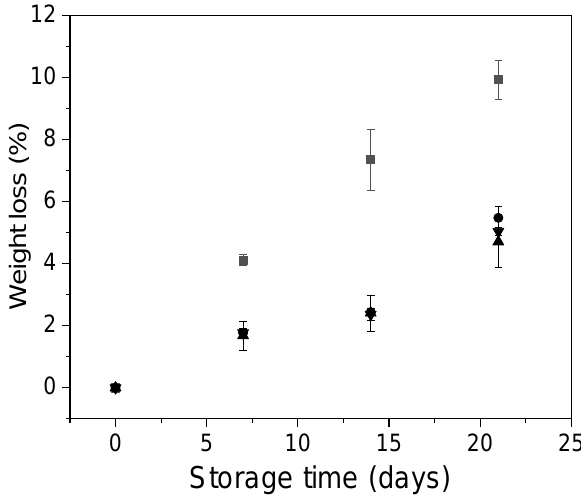
Figure 4. Behavior of the Andean blueberry weight loss during storage. Control ( ■ ), alginate (●), alginate/CNFs 0.1% ( ▲ ), alginate/CNFs 0.3% ( ▼ ). The changes in Andean blueberry soluble solids content, titratable acidity, and pH are shown in Figures 5 and 6. Control fruits showed a slight increase in their soluble solids content during storage (Figure 5). This behavior was probably due to both the water loss and the cell wall degradation caused by the fruit ripening. In the case of the coated samples, it was expected that the water loss caused an increase in the soluble solids contents. Therefore, it can be hypothesized that the edible coatings were able to prevent the cell wall degradation, avoiding the increase in the soluble solids content of the coated samples.